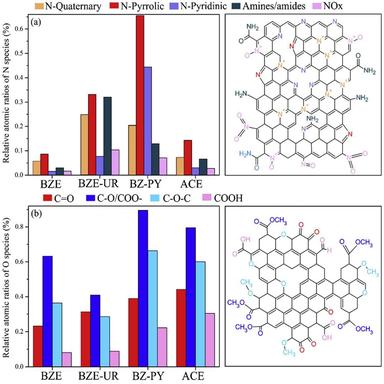
Relative atomic ratios of different chemical species (%). (a) Nitrogen doping and nitrogen functional groups and (b) oxygen functional groups. The corresponding models of doping and functional groups are shown on the right side. The results for N-CFSs synthesized using different nitrogen precursors (BZE, BZE-UR, BZ-PY, and ACE). N-CFS, nitrogendoped carbon fiber sponge; BZ-PY, pyridine-benzylamine; ACE, acetonitrile-ethanol; BZE-UR, BZE saturated with urea; BZE, benzylamine-ethanol.